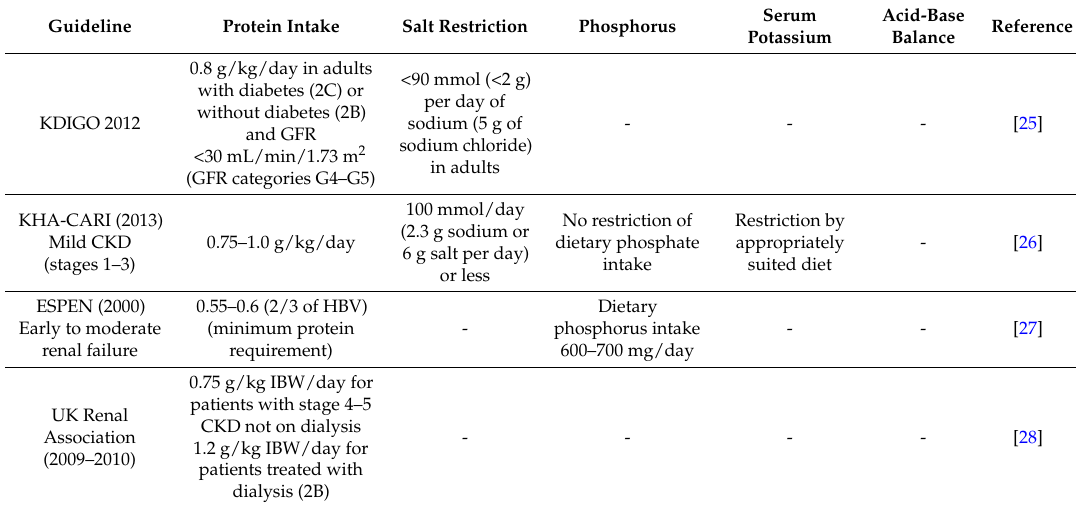
Table 1. Guidelines for patients with mild to moderate chronic kidney disease